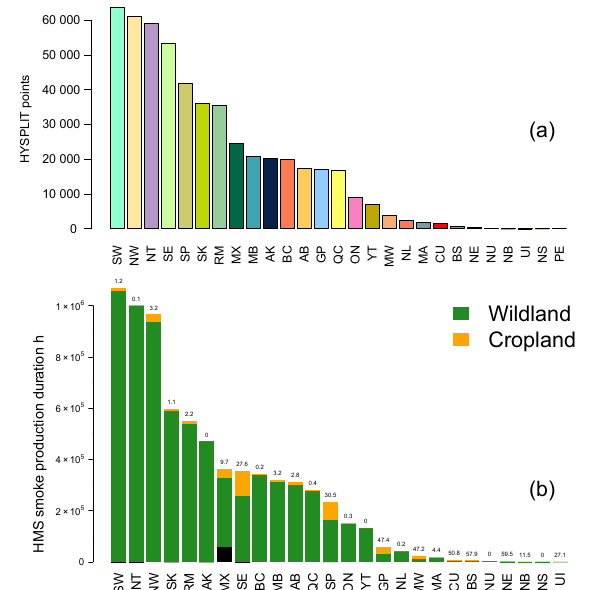
Figure 7. (a) Total HMS HYSPLIT point detections for all regions and months between 2007 and 2014. Region colors and abbrevia- tions are defined in Fig. 6. (b) Total HMS smoke production du- ration hours (SPDH) for the same time period. The number above each bar indicates the percentage of SPDH that are from croplands. The black portion of Mexico (MX) represents fires that occurred on land outside of the land-cover data extent used in this